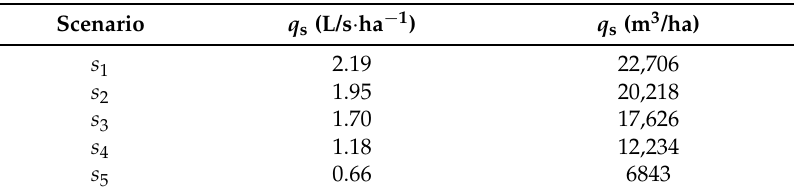
Table 4. Key parameters of water availability